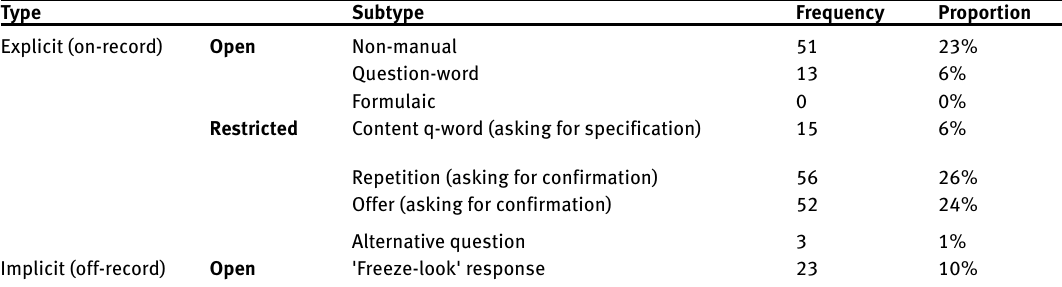
Table 3 Frequency of types of repair initiator in the LSA